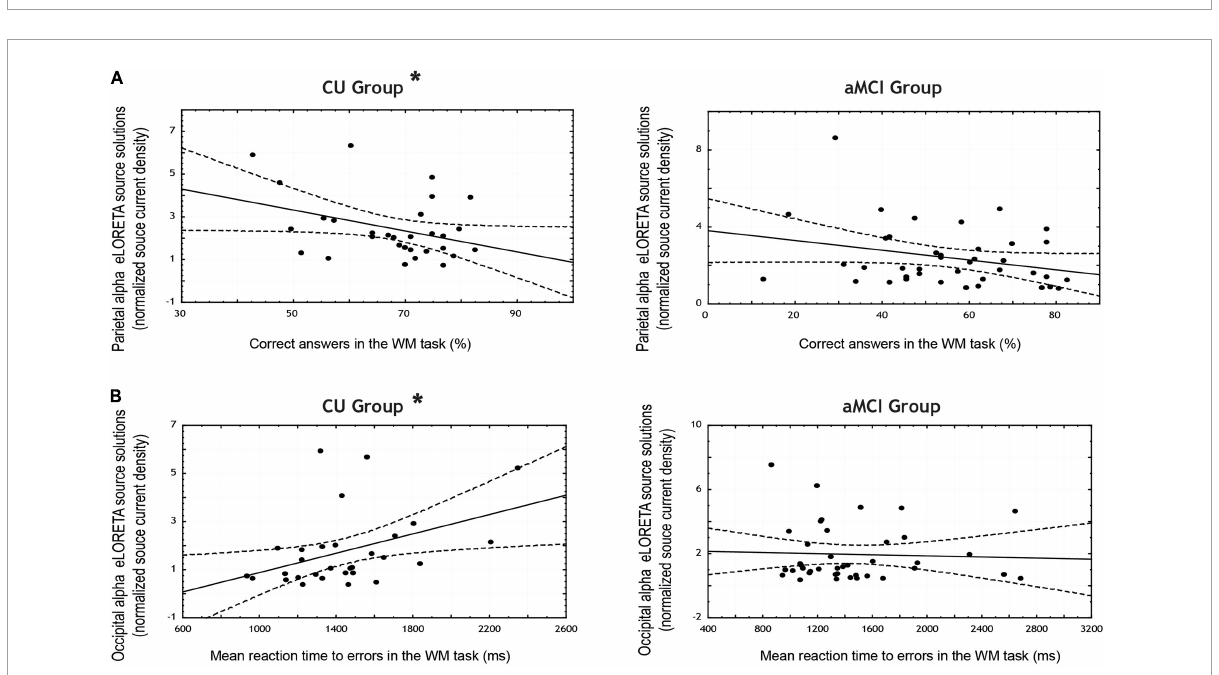
FIGURE3 Scatterplots for the CU and aMCI groups showing the correlation between eLORETA source solutions (normalized alpha current source density) of: (A) parietal alpha and the percentage of correct answers in the working memory task; and (B) occipital alpha and the mean reaction time to errors in the working memory task (in ms). Note that * indicates significant correlations ( p < 0.05 and r >